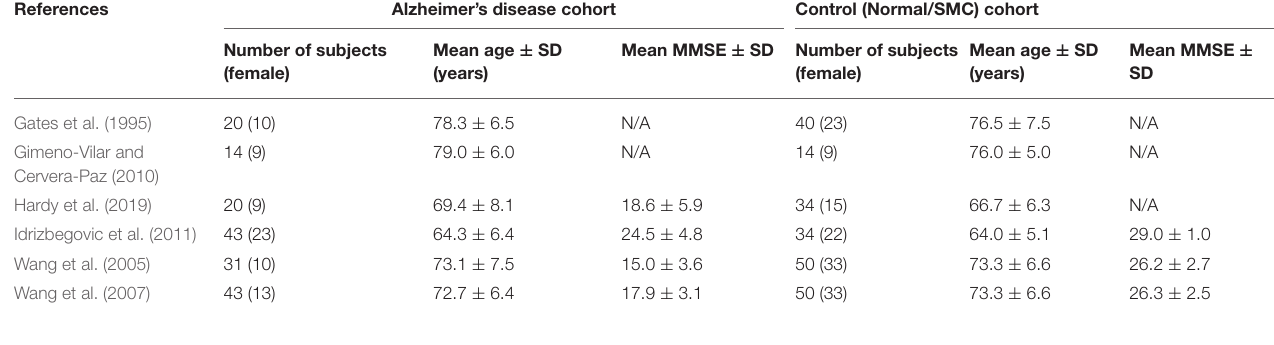
TABLE 2 | Demographics from each included study for subjects with Alzheimer’s disease and control subjects.